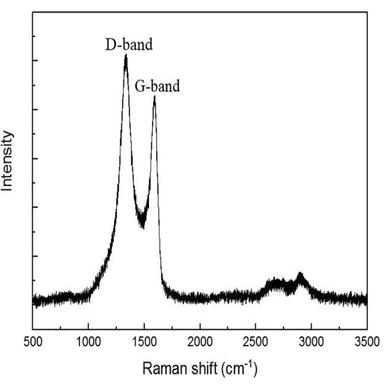
Raman spectrum of the NGPC.